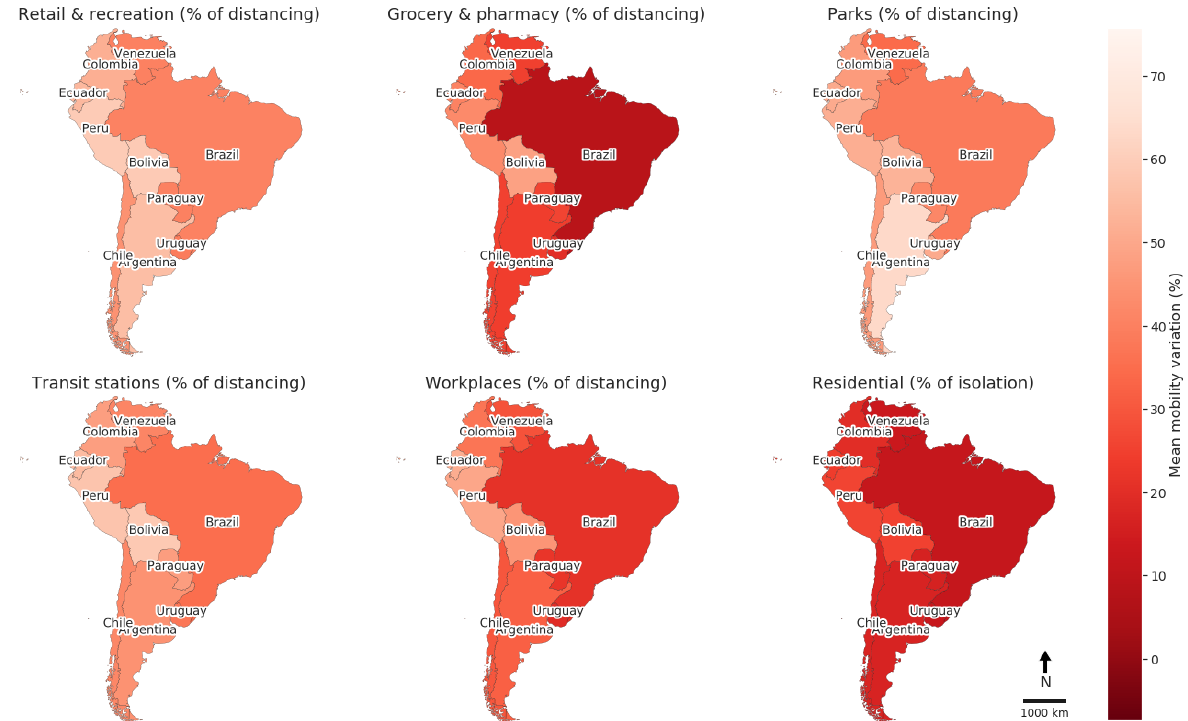
Figure 11. Average variation of mobility from baseline (3 January to 6 February 2020) for the selected countries of South America during the period from 15 February to 31 May 2020. Lighter colours indicate greater distancing or greater isolation in residential areas. Source of basic data: Covid-19 Community Mobility Reports,